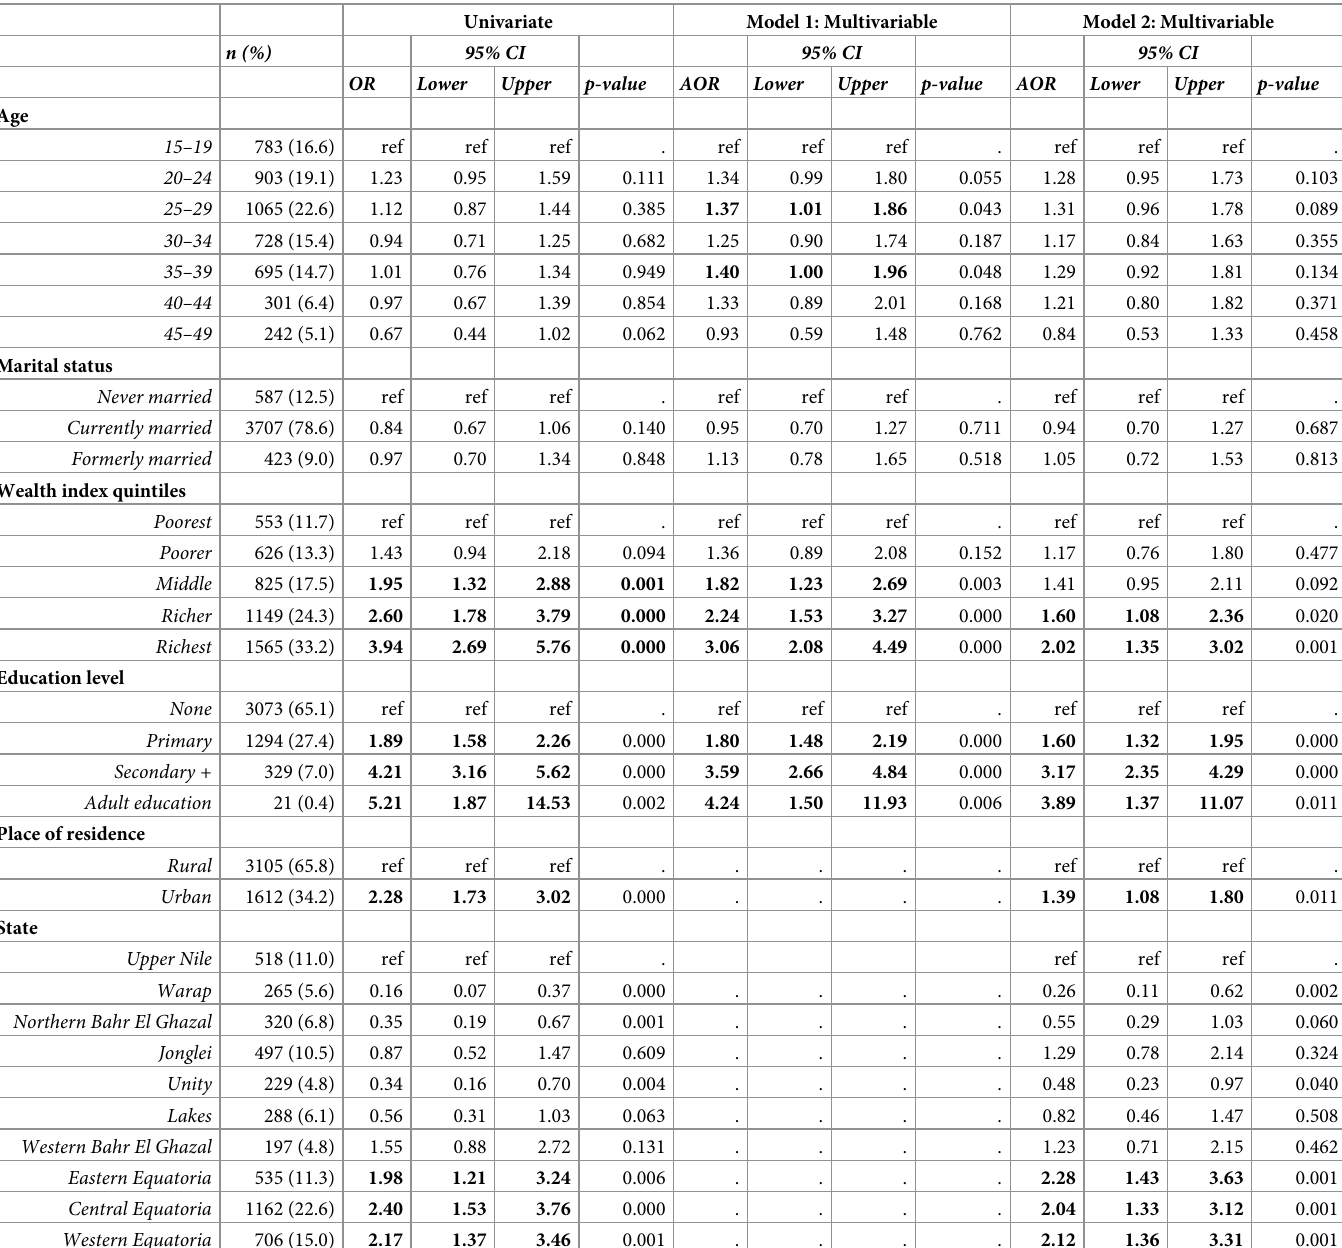
Table 3. Univariable and multivariable binary logistic regression for attitudes (n = 4717) towards people with HIV among women in South Sudan. Univariate Model 1: Multivariable Model 2: